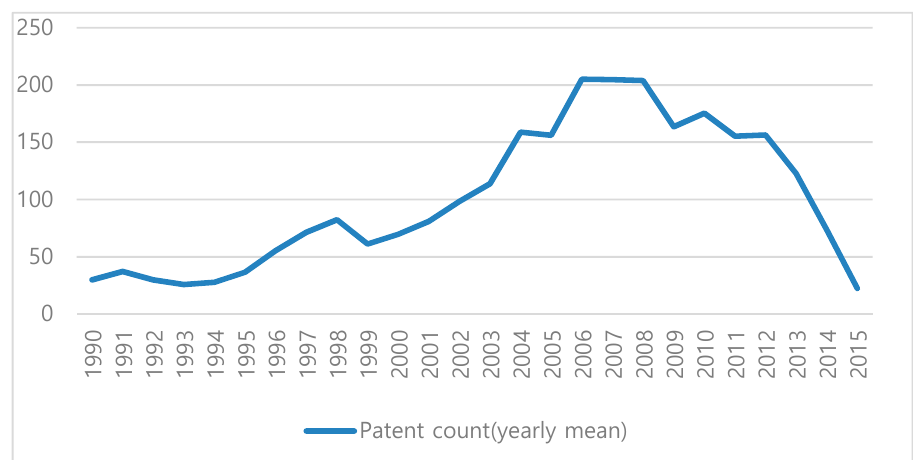
Figure 6. Average patent count of Korean firms.